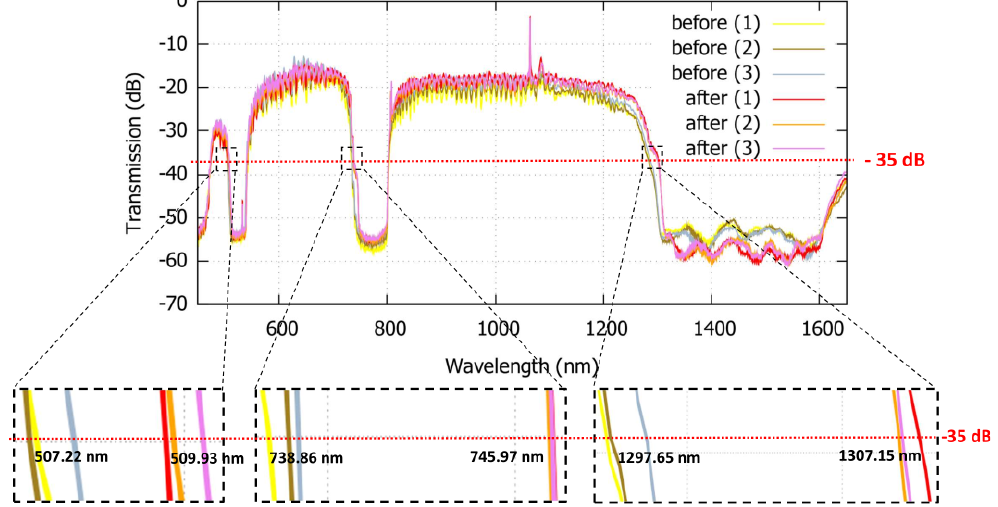
Figure 6. Transmission spectra of HC-TLF before and after infiltration with streptavidin solution, insets show the zoomed images of the high loss regions at the reference level of − 35 dB. For both the before and after infiltration, optical measurements repeated three times, shown by 1, 2, and